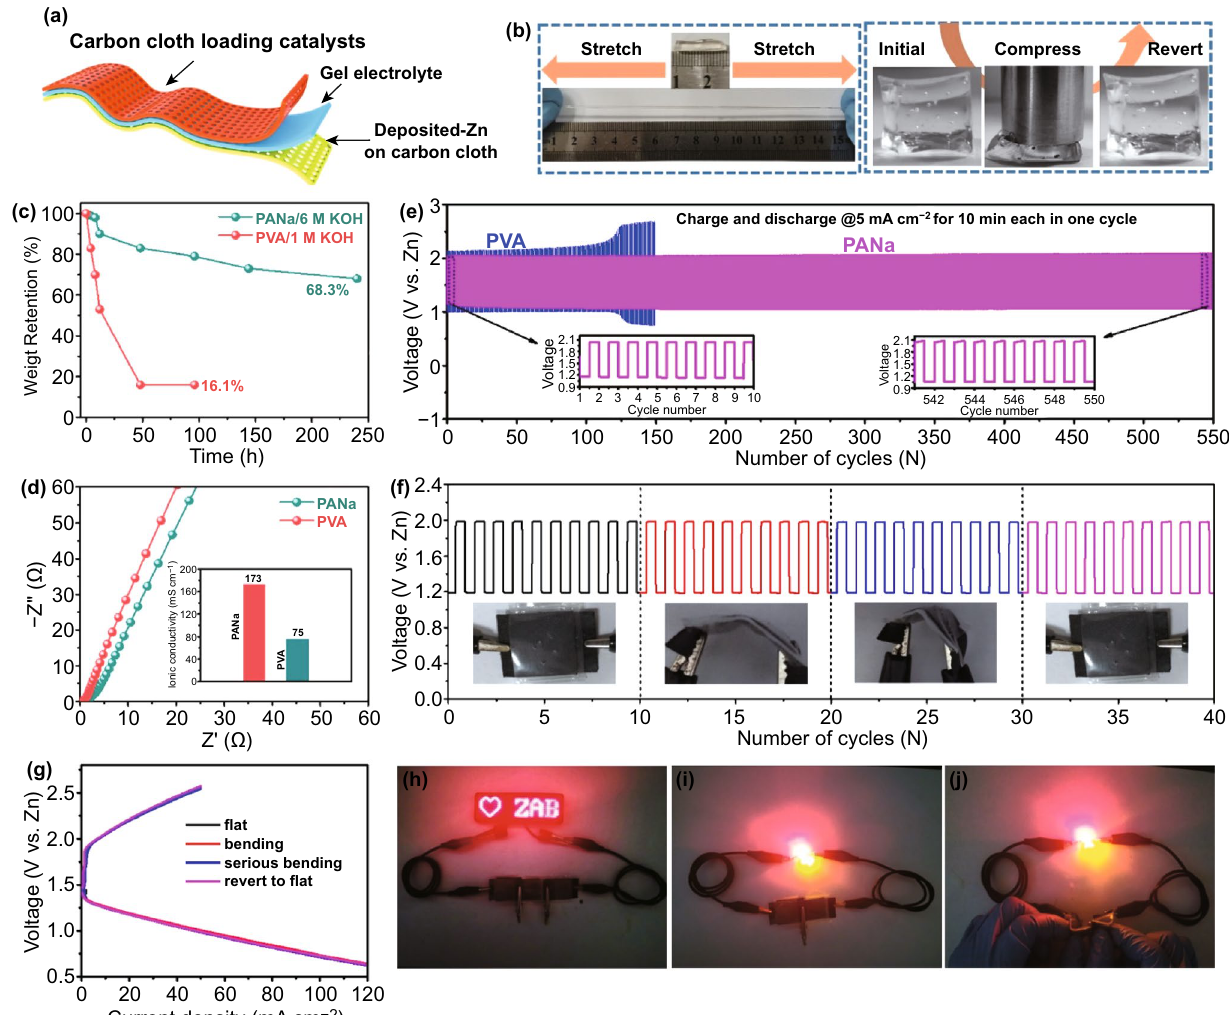
Fig. 8 a Schematic illustration and demonstration of the quasi‑solid‑state flexible ZAB. b Optical pictures of PANa electrolyte in the origi‑ nal state, tensile state and compression state. c Comparison of water holding ability and d EIS with PANa and PVA electrolytes. e Long‑term cycling performance by the use of PANa versus PVA electrolytes at a current density of 5 mA cm −2 . f Cycling performances and g charge–dis‑ charge profile of the flexible ZAB under different bending states. h‑j Optical pictures of a LED panel and three LED indicators powered by two flexible ZABs connected in series; the batteries in j are in the bending